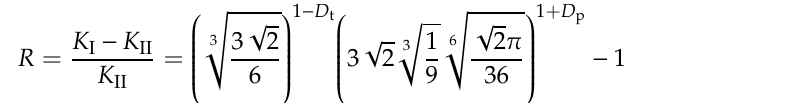
Figure 9. Effect of pore area fractal dimension on permeability of porous media. Figure 9. E ff ect of pore area fractal dimension on permeability of porous